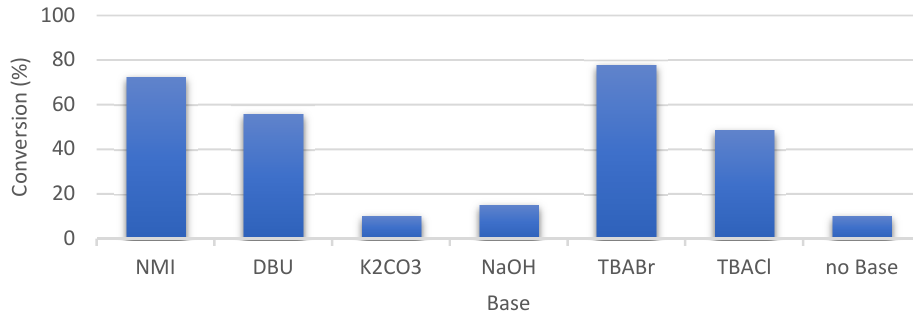
Figure 11. Optimization of the reaction parameters for the oxidation of VAL to VN with respect to the base type. Reaction conditions: 1 mmol vanillyl alcohol, 0.4 mol.% NiFe 2 O 4 , air, rt, 10 mL solvent, 0.8 mol.% TEMPO, base 2 equiv., and 6 h reaction time. Conversion was determined by GC analysis using 1,2-dichlorobenzene as the internal standard.